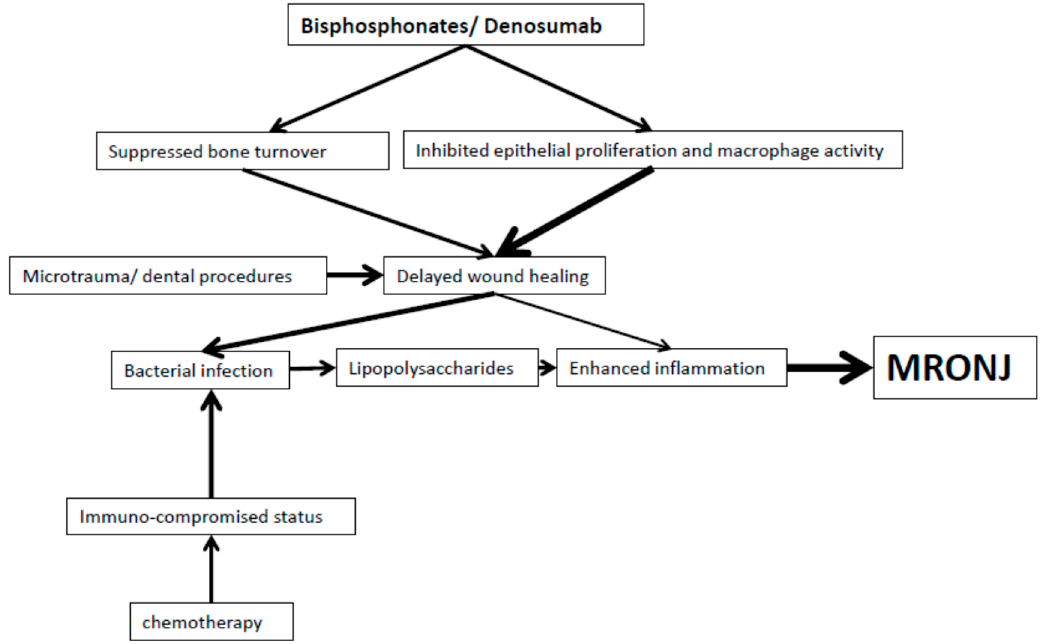
Figure 2. Flowchart shows the current hypothesis of the pathophysiology of MRONJ.